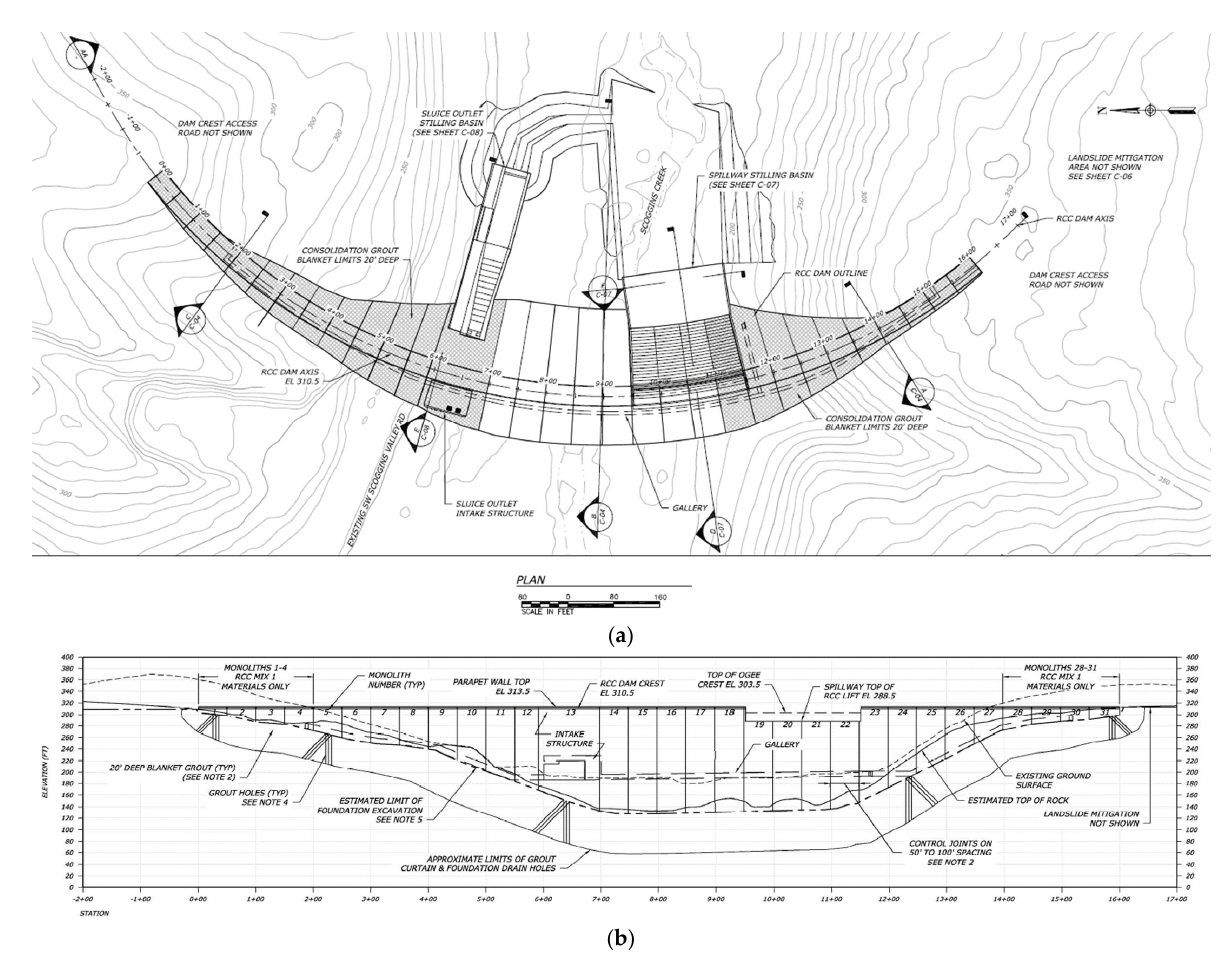
Figure A2. Scoggins RCC Dam: ( a ) Plan layout; ( b ) Profile (looking downstream). Stationing and elevation scales are in feet. Reference to notes on these figures are related to notes provided on the feasibility design drawings and have not been included here.